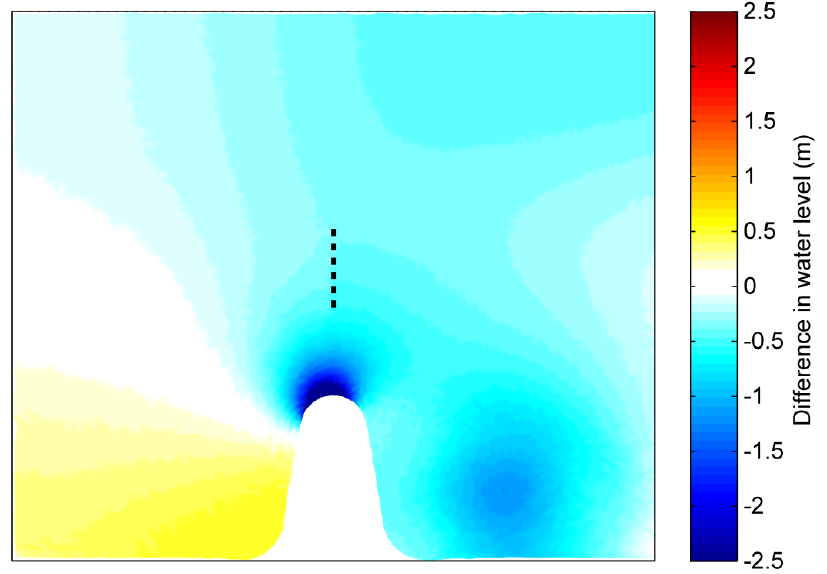
Figure 11. A plot showing the difference in water level between the coastal area model and the BEM-CFD model (fixed lid at a 30-m water